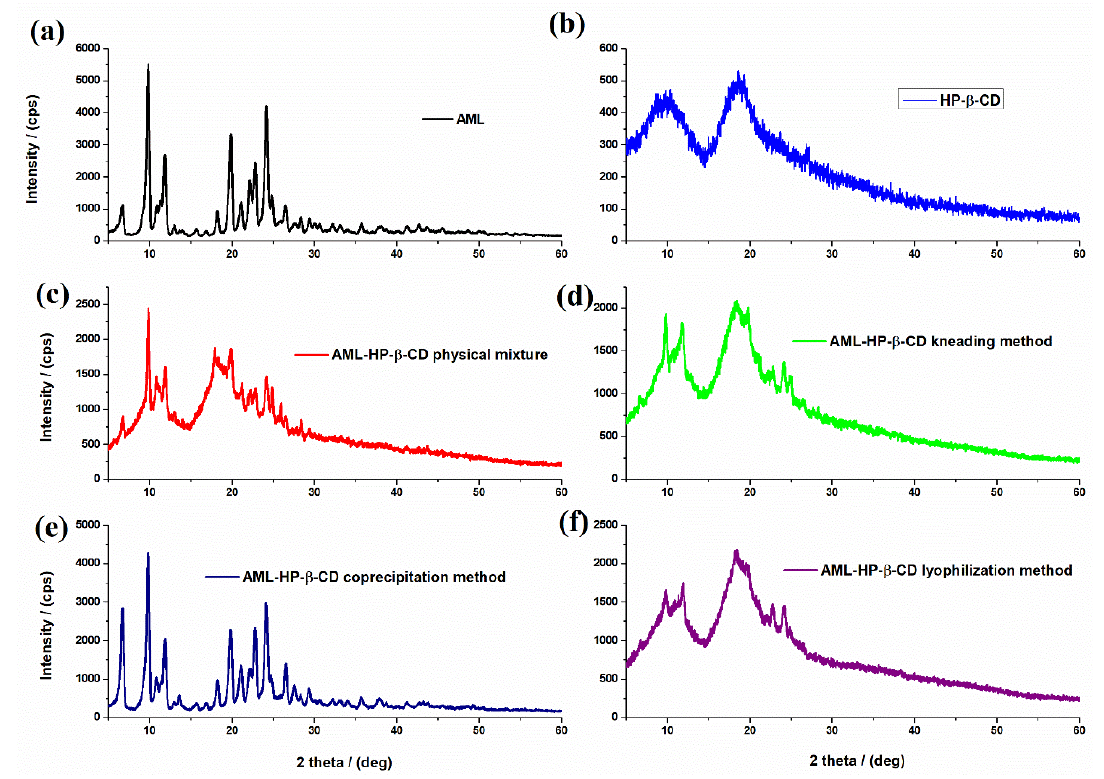
Figure 5. XRD pattern of ( a ) AML, ( b ) HP- β -CD, ( c ) AML-HP- β -CD physical mixture, ( d ) AML- HP- β -CD kneading method, ( e ) AML-HP- β -CD coprecipitation method, and ( f ) AML-HP- β -CD lyophilization method.